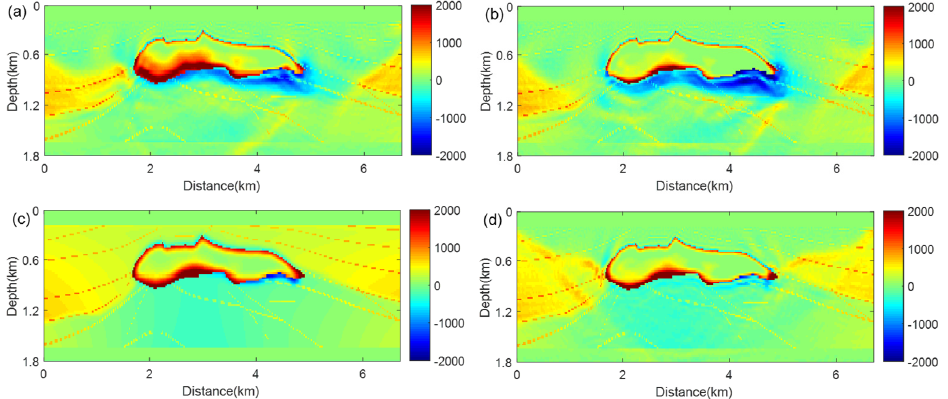
Figure 11. Difference profiles. ( a ) Difference profile between Figures 4a and 10b. ( b ) Difference profile between Figures 4a and 10d. ( c ) Difference profile between Figures 4a and 10f. ( d ) Difference profile between Figures 4a and 10g.